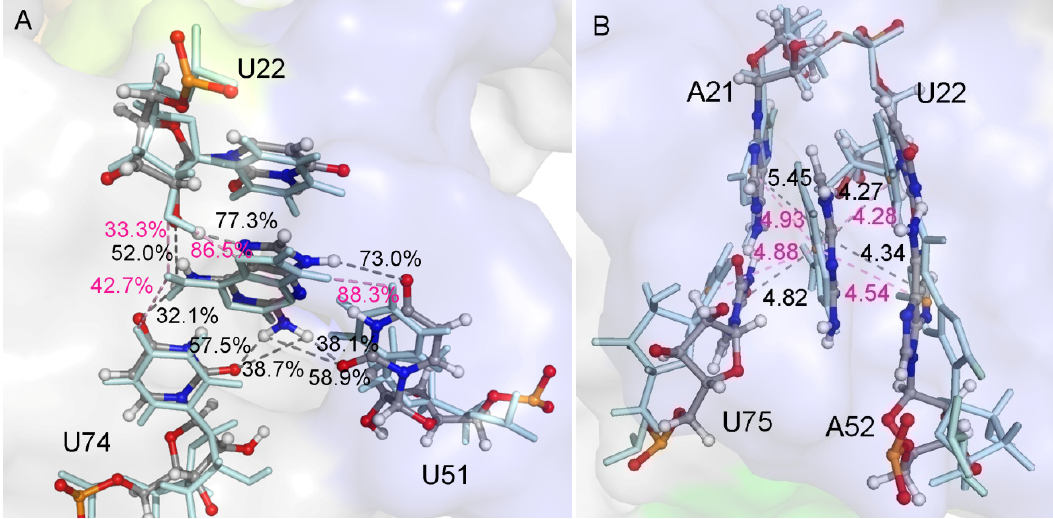
Figure 3. ( A ) Superimposition of two representative structures of GR(C74U) complexed with ADE and 6AP based on three nucleotides. The occupancies of hydrogen bonds (H-bonds) formed between three nucleotides and ligands are labeled. ( B ) Superimposition of two representative structures of GR(C74U) complexed with ADE and 6AP based on four nucleotides which interacted with ligands via a van der Waals interaction. The van der Waals interactions are labeled with distances. The ligands and nucleotides in the ADE complex are shown in a pale cyan color with stick representation. In the 6AP complex, they are shown using a stick-and-ball representation colored by elemental name. The labels in ADE and 6AP complexes are shown in pink and black colors, respectively.